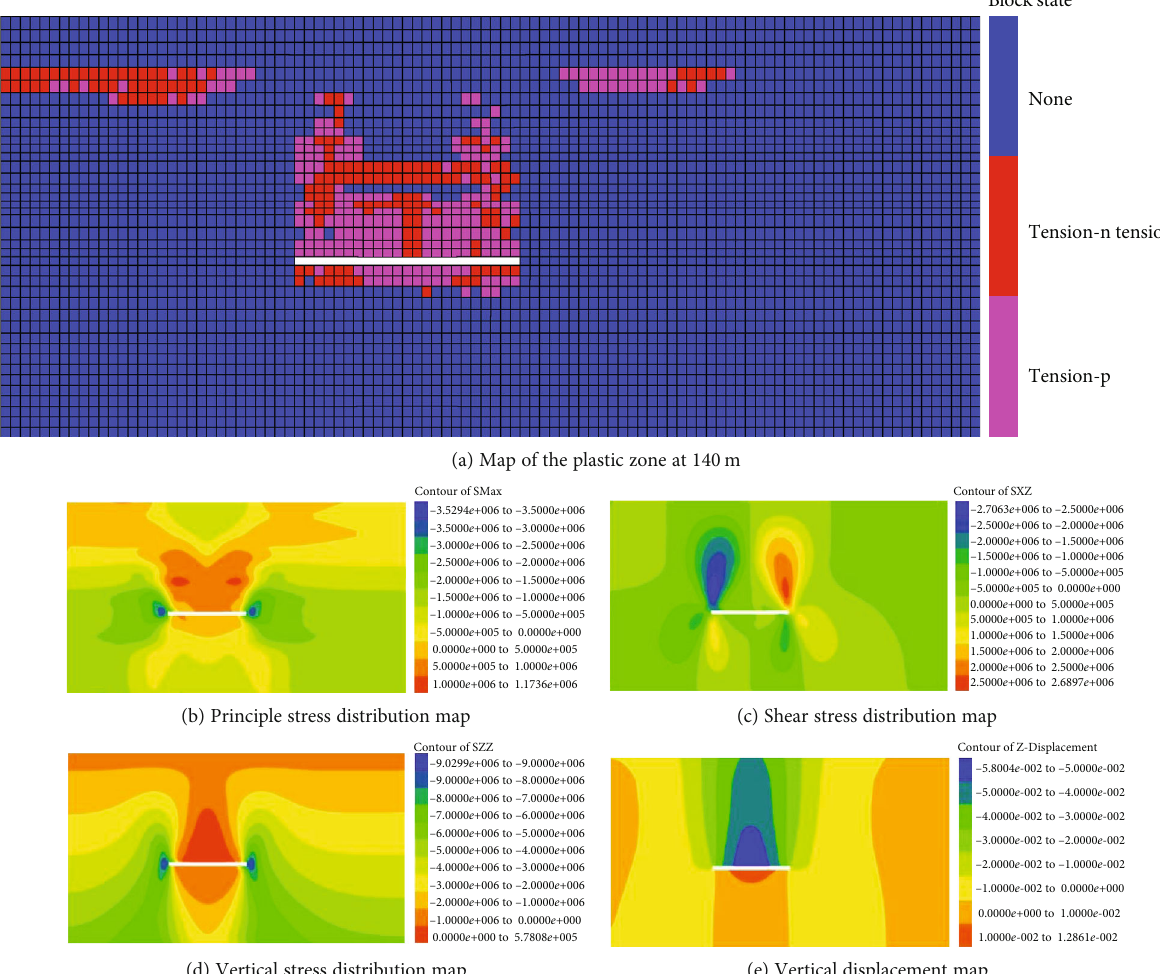
Figure 11: Plastic zone and stress distribution